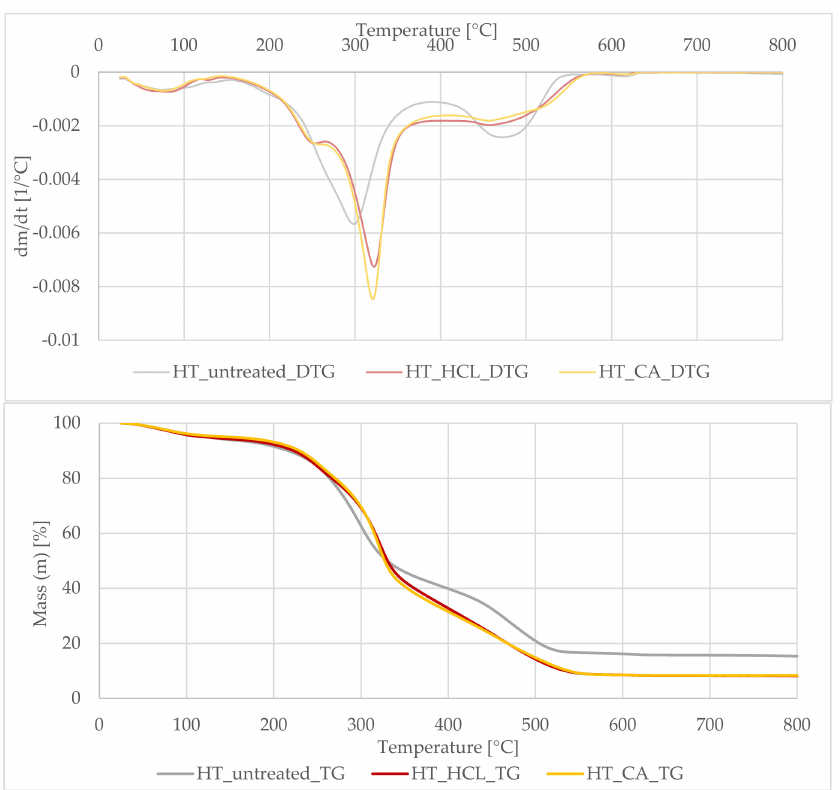
Figure 2. The thermogravimetric (TG) curves ( down ) and the derivative of the TG versus time (DTG) curve ( up ) of horsetail untreated and treated with